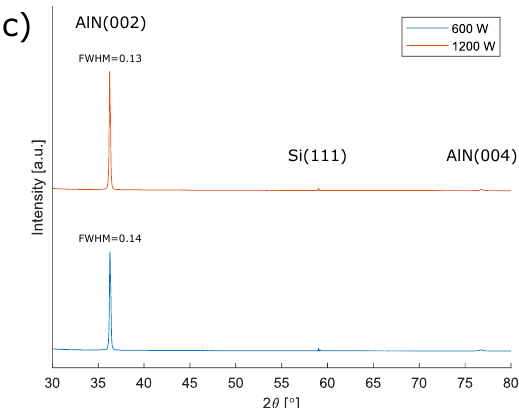
Figure 1. XRD spectra of AlN films grown on Si(111) where ( a ) processing pressure is varied while magnetron power is kept constant at 600 W and N 2 /Ar ratio at 27%, ( b ) magnetron power is varied while processing pressure is kept constant at 0.2 Pa and N 2 /Ar ratio at 27%, and ( c ) magnetron power is varied while processing pressure is kept constant at 0.2 Pa and N 2 /Ar ratio at 50%. FWHM of the AlN(002) peak is indicated for each spectrum.